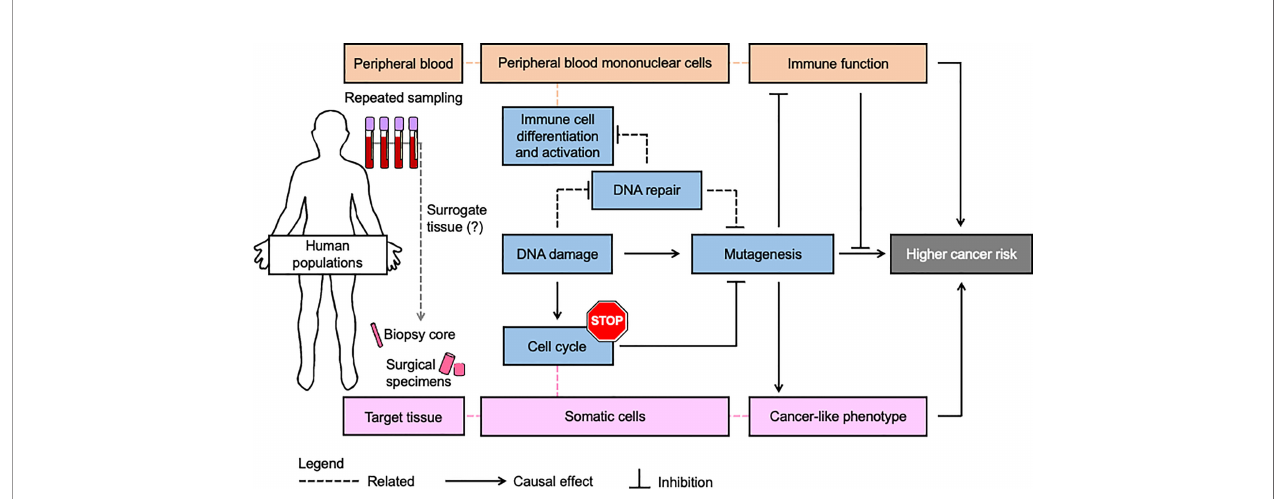
FIGURE 2 | Simultaneous assessment of genome integrity and immune function may be a more robust strategy for personalized prevention and treatment of cancer. Most population studies use blood samples to assess genome integrity and immune function because blood draws are less invasive than the procedures for collecting other tissues from human subjects. A key assumption is that fundamental processes in cancer etiology (blue boxes) as measured in blood (red boxes) are suf fi ciently related to be considered a surrogate for the corresponding target tissue (pink boxes). Since blood and its components are heavily involved in immune processes, this tissue can provide extensive insights into immunophenotype. Likewise, lymphocytes provide extensive insights into inter-individual variation in genome integrity mechanisms, including those underlying risk of numerous solid malignancies as reviewed herein. In addition to its role in preventing mutagenesis and immunosuppression that can be induced by DNA damage, DNA repair is extensively involved in the differentiation and activation of immune cells. Nevertheless, variation in immune function and genome integrity pathways is independent and challenging to predict from genetics and indirect genomic markers. Therefore simultaneous functional assessment of DNA repair activities and immune function in studies using blood may improve the accuracy and precision of cancer risk estimates beyond what is possible when considering either process